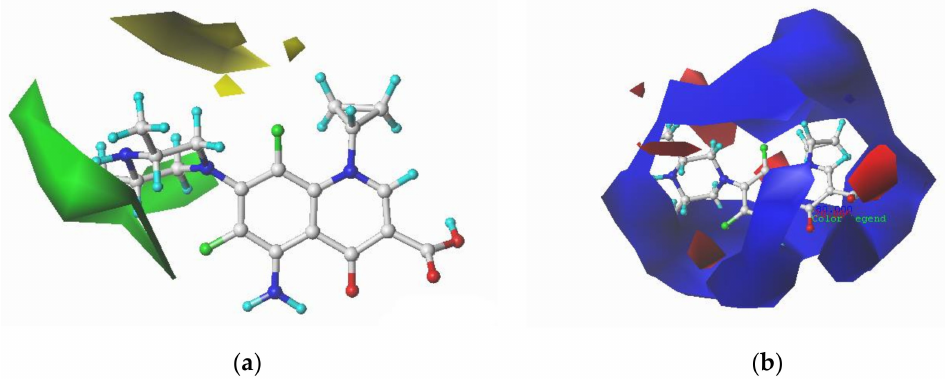
Figure 4. 3D contour maps of the CoMFA model for sparfloxacin (SPA): ( a ) steric and ( b ) electrostatic